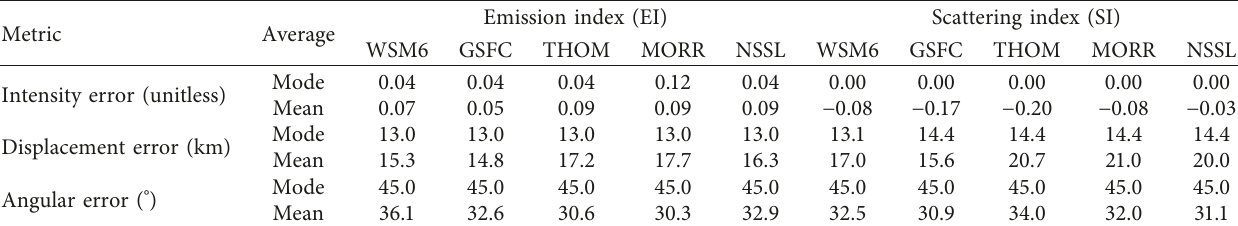
Figure 8: As in Figure 7, except for the scattering index Table 4: Three error component statistics of the OF field.